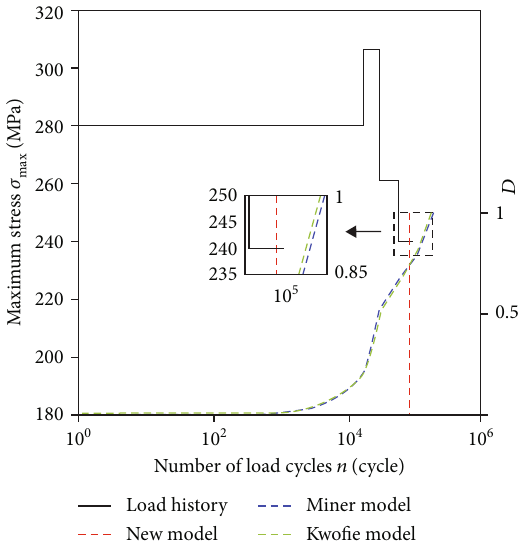
Figure 11: Comparison of experimentally obtained and corresponding theoretical remaining life values predicted by the Miner, Kwo fi e, and proposed new model for 6082-T6 aluminium alloy under four-level cyclic loading in the range 260 – 275 – 290 –